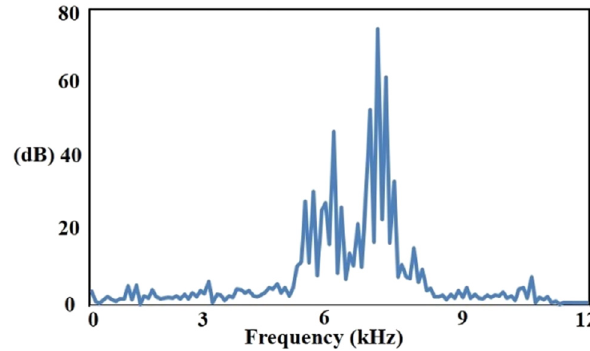
Figure 17: Frequency domain signal ( normal bearing ) .